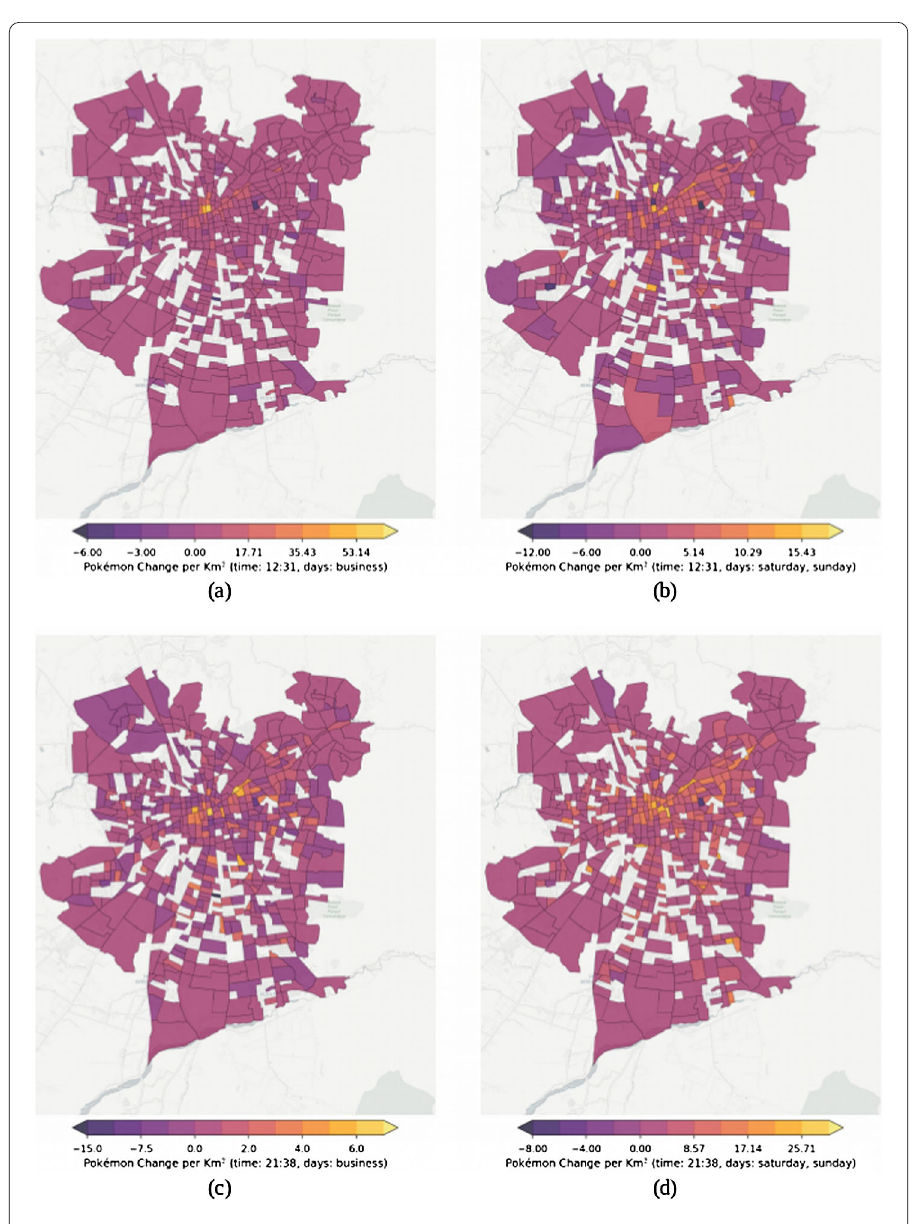
Figure 6 Choropleth maps of the difference between the means of connected devices per zone, before and after the launch of Pokémon Go. Top row shows differences at 12:31 PM on business days (a) and weekends (b) . Bottom row shows differences at 9:38 PM on business days (c) and weekends (d) . The differences are adjusted by zone area, and consider business and weekend days as different groups. A zone with a value of 0 did not show differences between